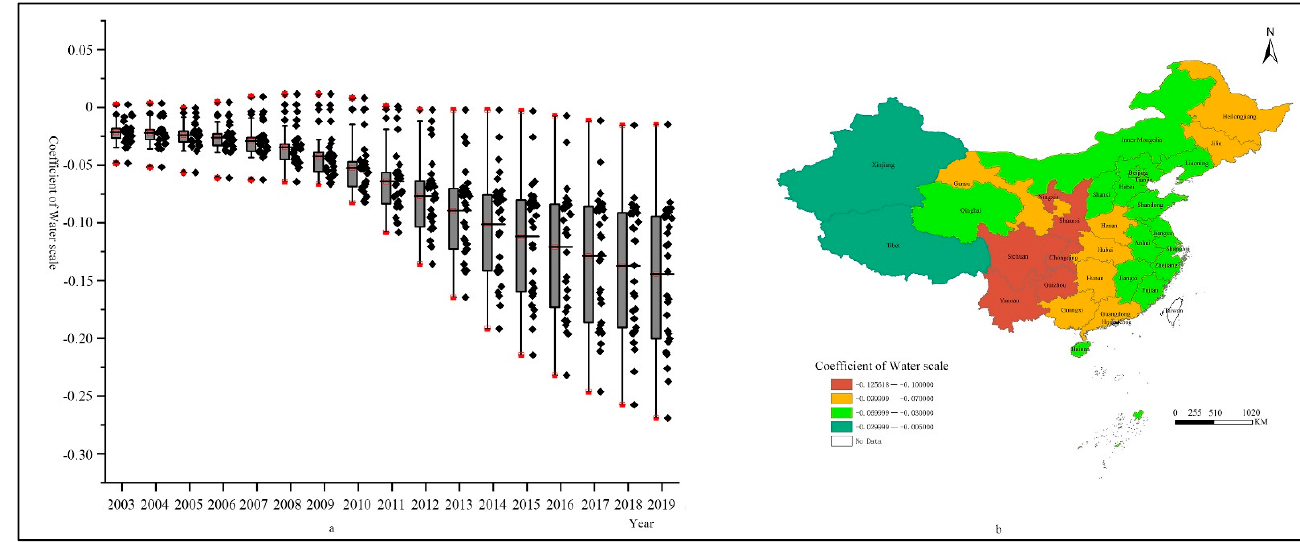
Figure 9. ( a ) Box-plot of regression coefficients of the water scale; ( b ) Distribution of mean value of regression coefficients of the water scale.